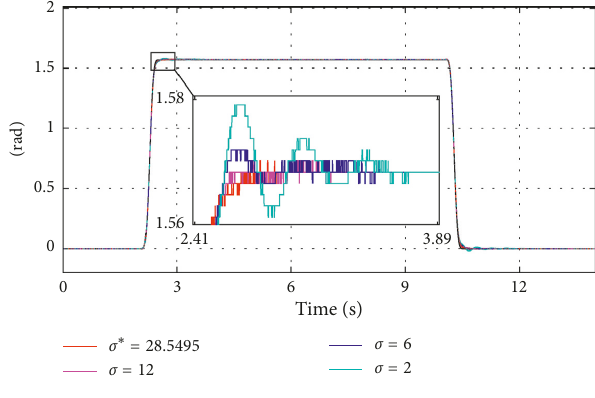
Figure 11: Trajectory tracking results.